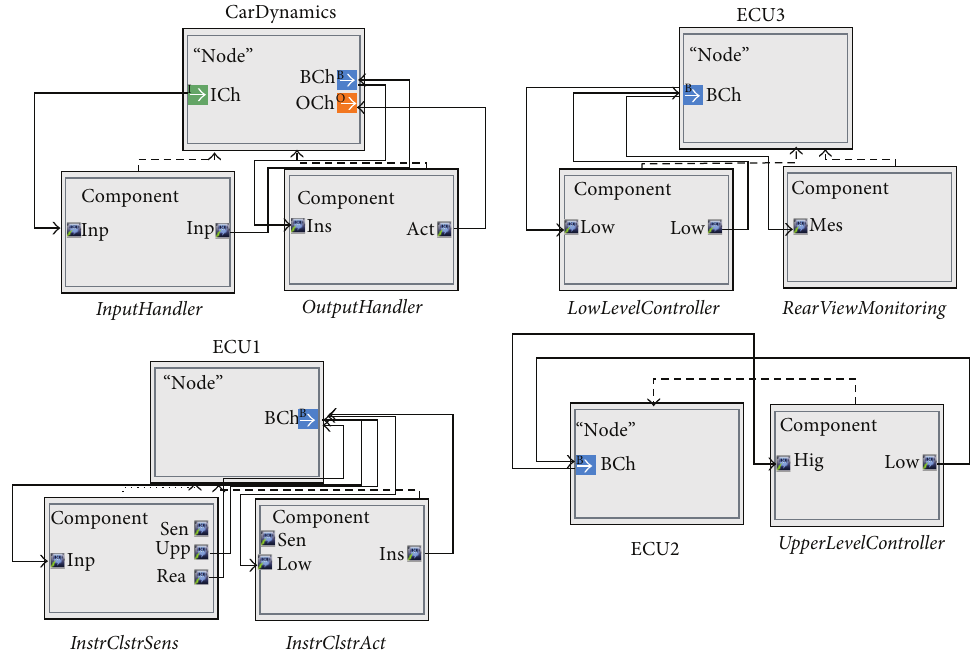
Figure 10: Platform deployment aspect of ACC controller.